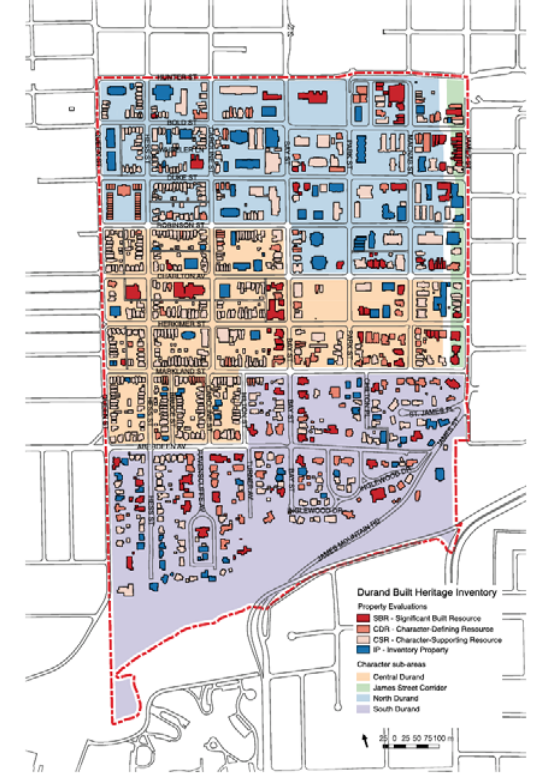
Figure 5. Sub Area and Property Classification Results